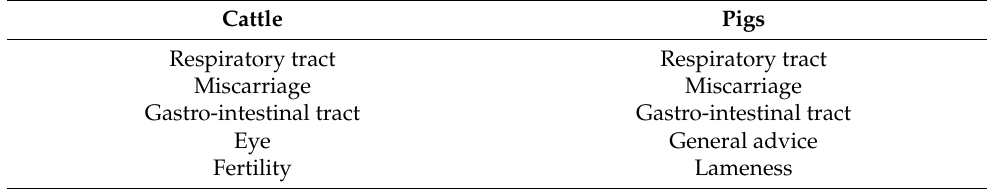
Table A1. Categorization reported clinical signs at the veterinary